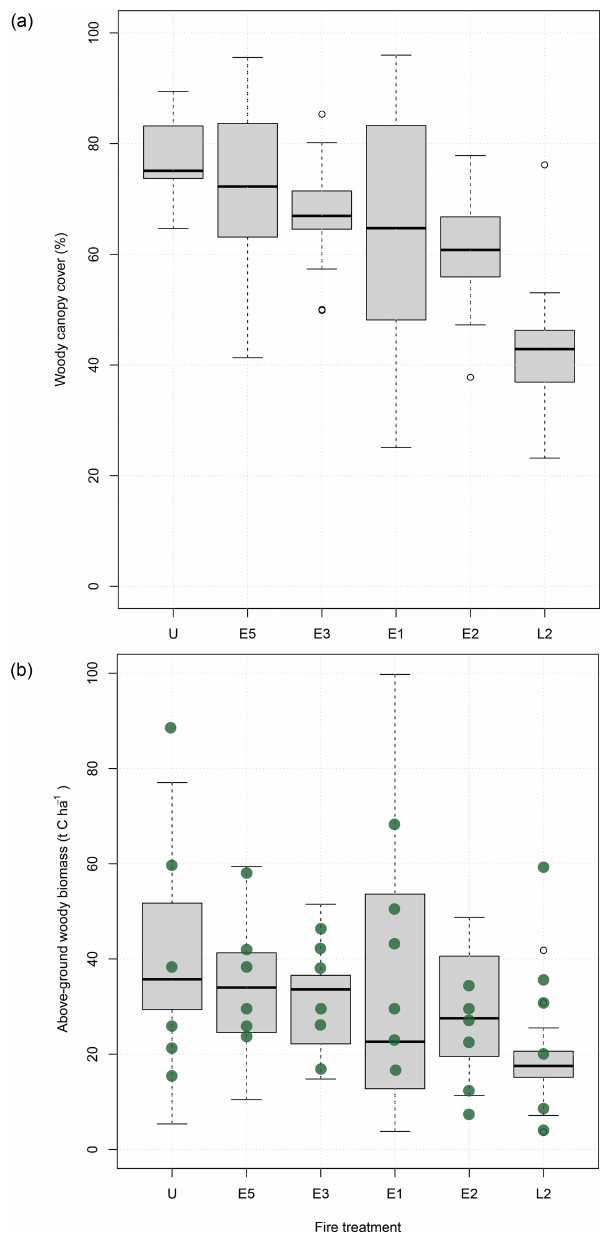
Figure 4. Relationship between fire treatments and (a) woody canopy cover and (b) woody biomass. Fire treatments ordered ac- cording to increasing fire intensity. Green dots in (b) indicate field- measured values derived from 30m × 30m subplots.